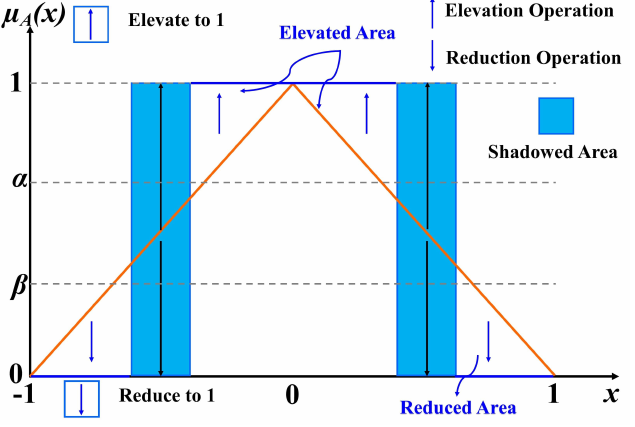
Figure 1. Characterization of shadowed set